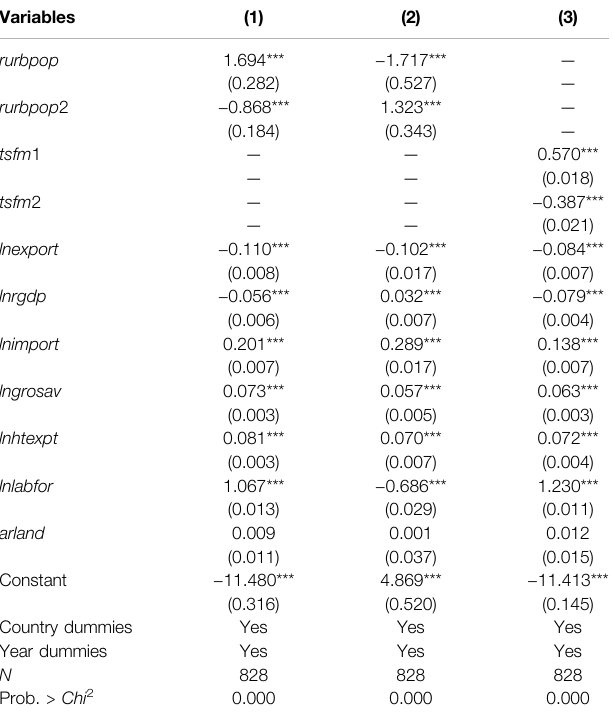
TABLE 3 | Results of robustness check. TABLE 4 | Results of the transformative role of government